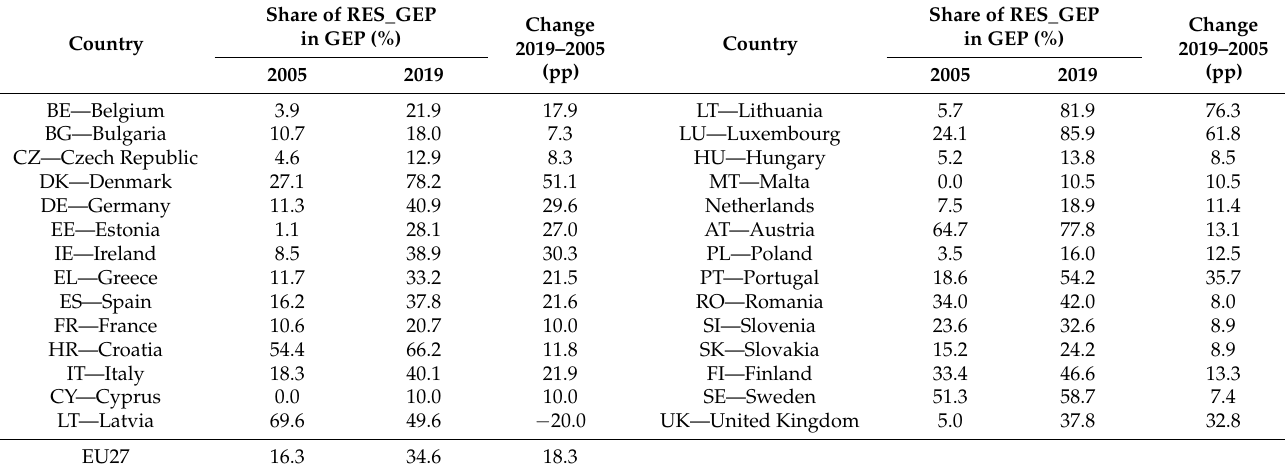
Table 1. Share of electricity produced from renewable sources and biofuels in the total electricity production in individual EU countries in 2005 and 2019. Share of RES_GEP in GEP Country